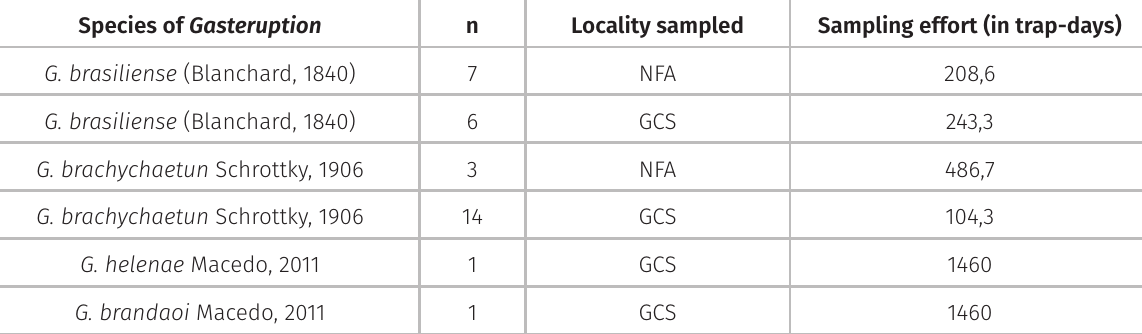
NFA: natural field area, with low cattle grazing intensity; GCS: natural grassland area associated to palm forest under grazing of cattle and